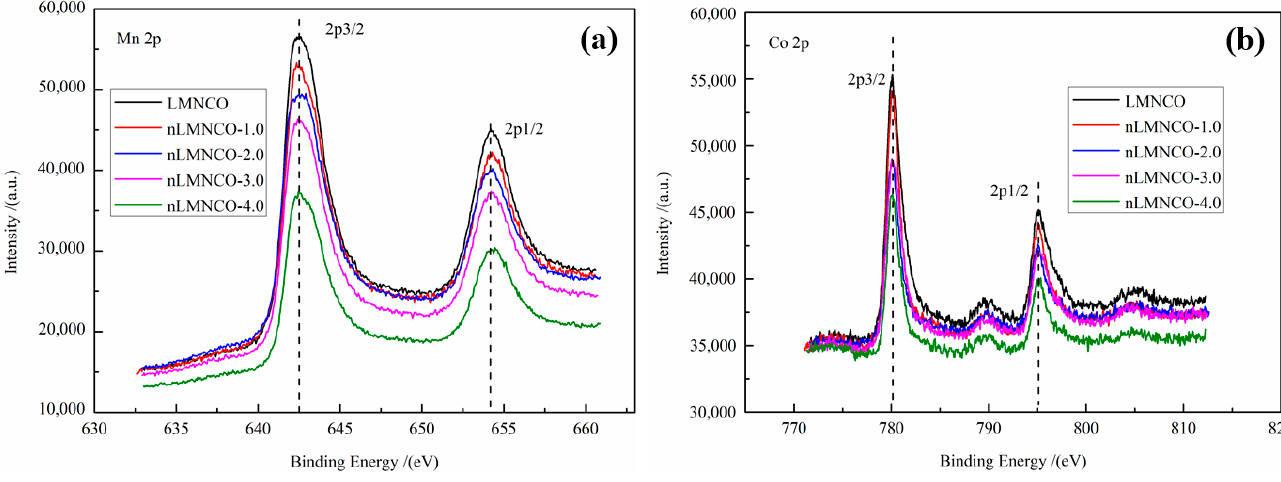
Figure 4. ( a ) Mn2p and ( b ) Co2p XPS patterns of cathode materials.